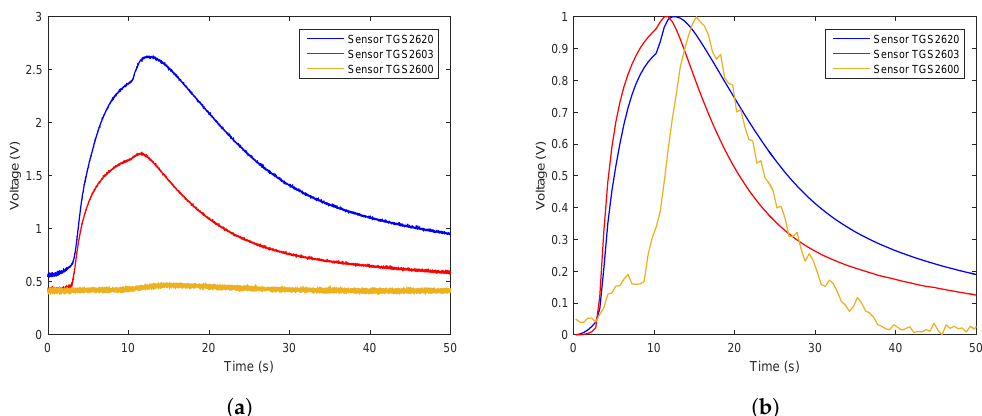
Figure 7. Time series of ethanol raw data and the data after preprocessing. ( a ) Shows the representative example of the time series of the original response curves of the sensor array for gas ethanol. ( b ) Shows the results after preprocessing.